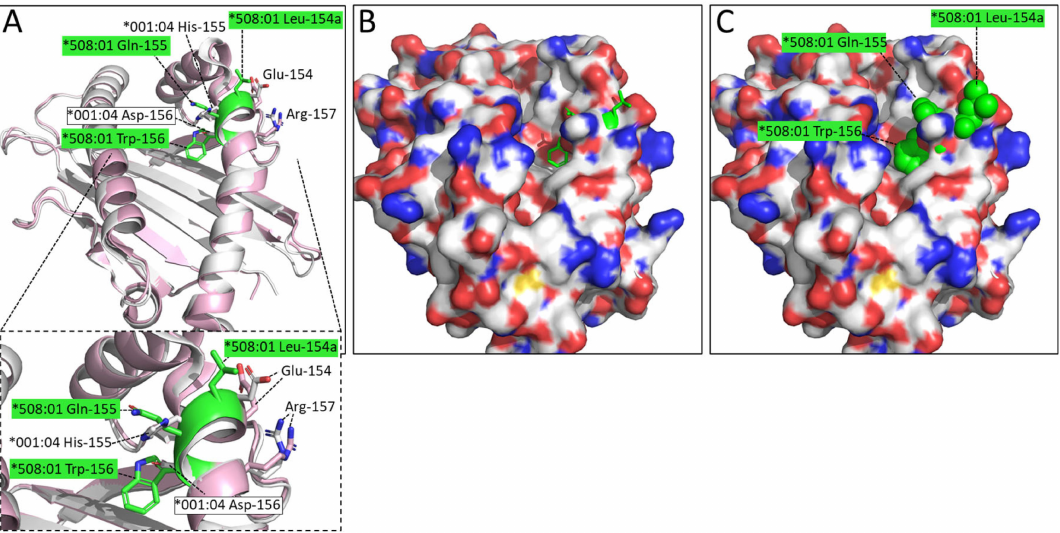
Figure 6. The LQW motif in pDLA-88*508:01 (PDB 5F1I) creates marked differences compared to pDLA-88*001:04 by having Leu-154a at the top of the α 2 helix and Trp-156 at the border between the D and E pockets. Superposition of α 1 α 2 domains: (( A ), with zoomed-in view) pDLA-88*001:04 in white and pDLA-88*508:01 in pink, the sidechains of their positions 154-to-157 in sticks format and element coloring; the residues of the LQW motif are highlighted in green; ( B ) Same as ( A ) although in a slightly different orientation to show the open groove better, and with the DLA-88*001:04 α 1 α 2 domain shown in surface format with element coloring and the sidechains of residues 154a-to-156 of DLA-88*508:01 154a-to-156 shown in all-green sticks format; ( C ) same as ( B ) but with the DLA-88*508:01 154a-to-156 residue sidechains shown in spheres